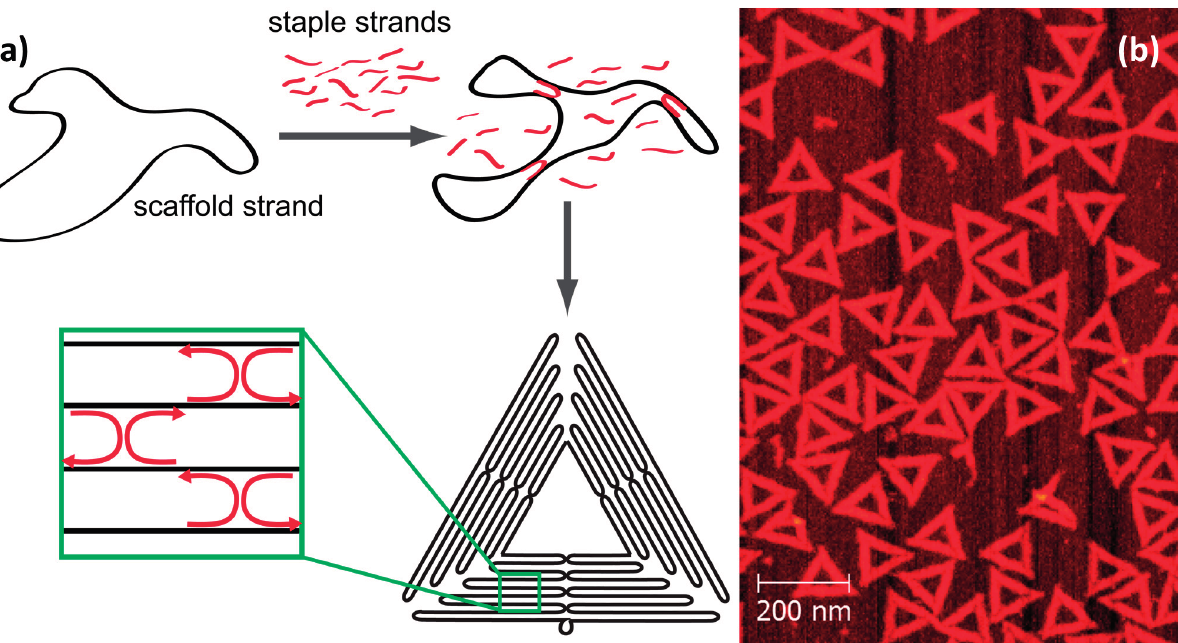
Figure 1. ( a ) Scheme for synthesizing a triangular DNA origami nanostructure: A circular single-stranded scaffold is folded into a triangular shape by addition of ~200 specifically binding oligonucleotides, so-called staple strands; ( b ) Atomic force microscopy (AFM) image of the resulting triangular DNA origami immobilized on a mica